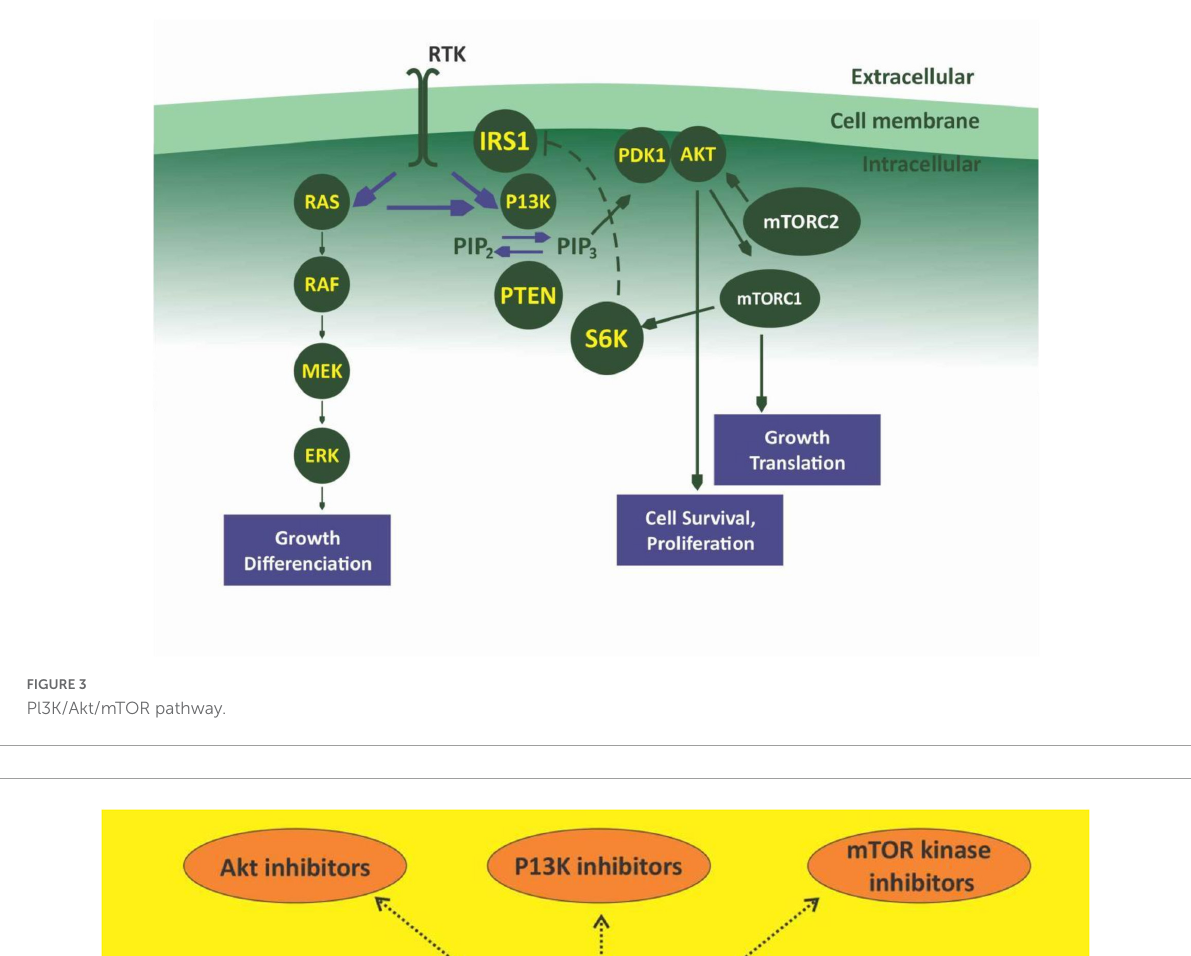
FIGURE3 Pl3K/Akt/mTOR pathway.